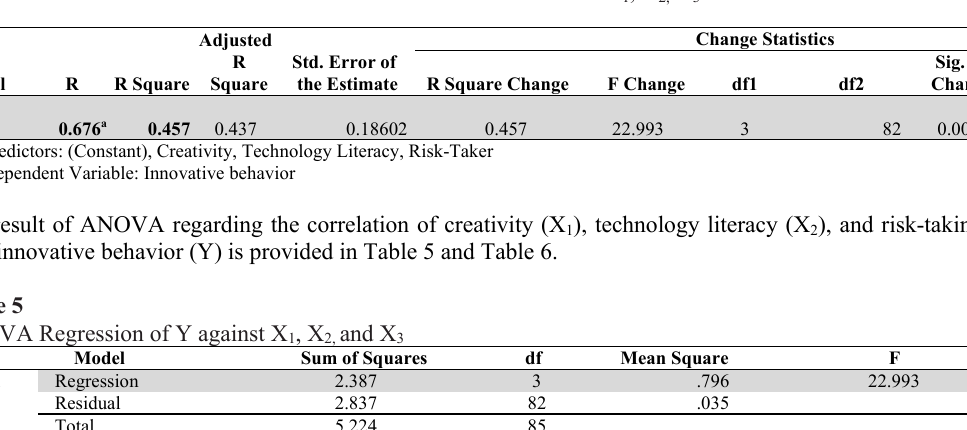
Correlational Coefficient & Determinant Coefficient between Y with X 1 , X 2, X 3